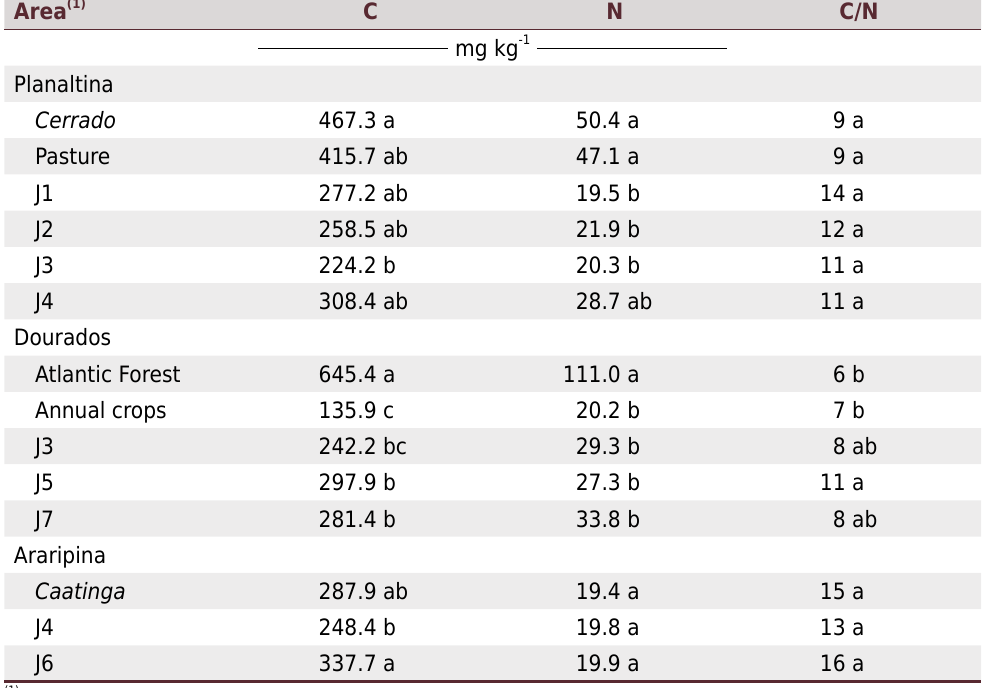
Table 3. Concentrations of carbon and nitrogen and C/N ratio of the microbial biomass of soils with different uses, at a depth of 0.00-0.10 m in Planaltina-DF, Dourados-MS, and Araripina-PE, Brazil Area